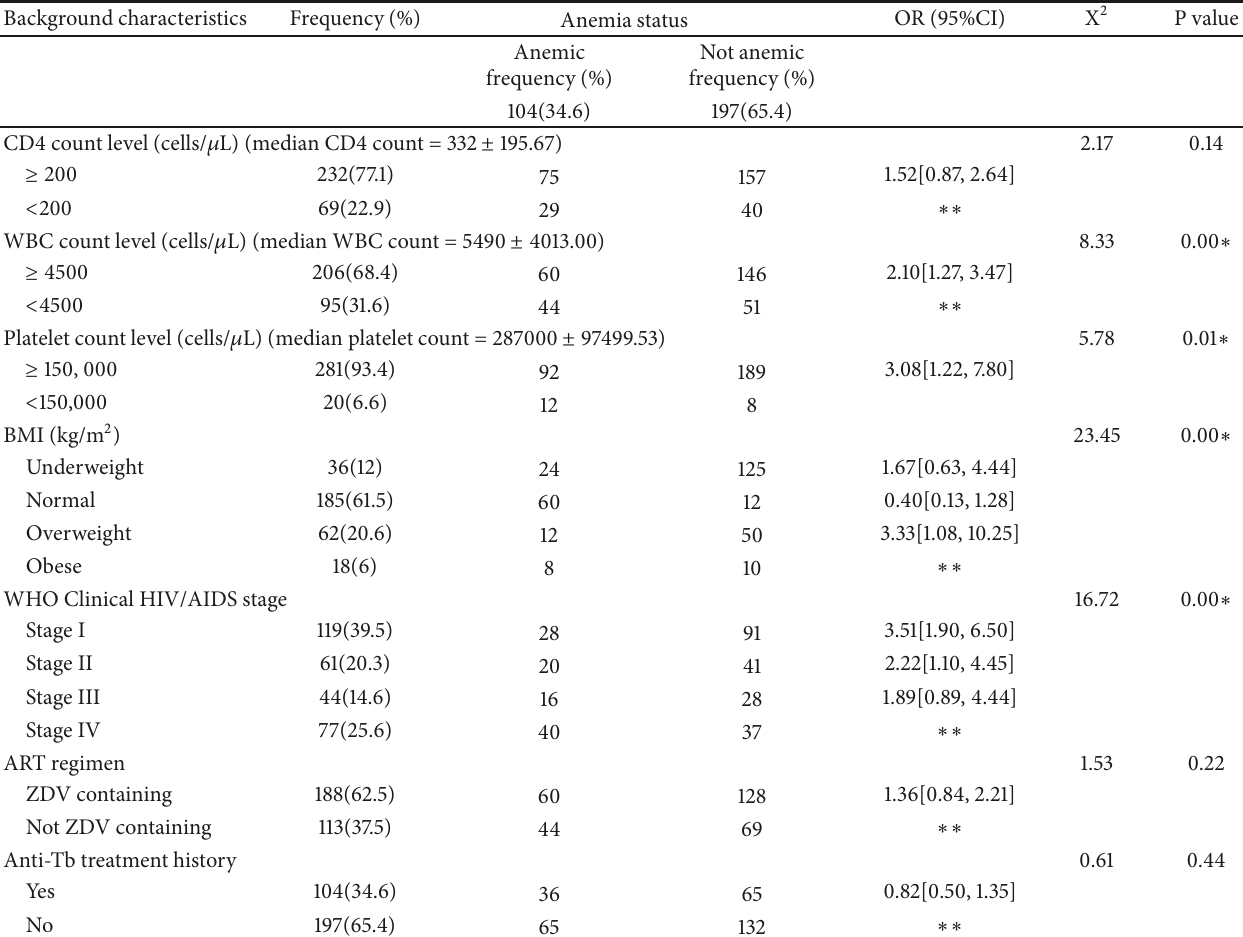
Table 3: Clinical characteristics and their association with anemia under unadjusted logistic regression analysis (n = 301). Background characteristics